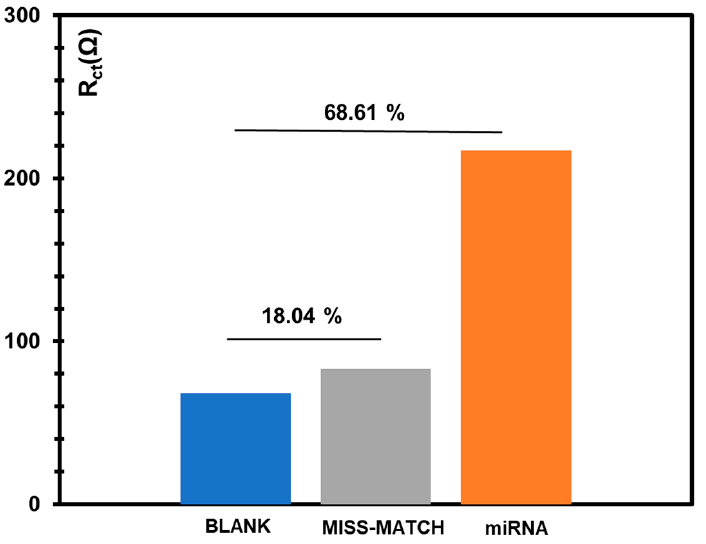
Figure 5. Response of the microRNA 21-5p biosensor against a mismatched miRNA sequence (miRNA concentrations of 0.1 pM).